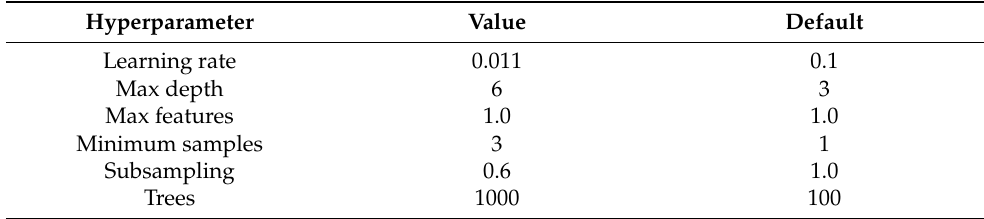
Table 3. Chosen hyperparameter settings after optimization via cross-validation. Note that “Max features” and “Subsampling” are float numbers denoted as a fraction of the total number of fea-